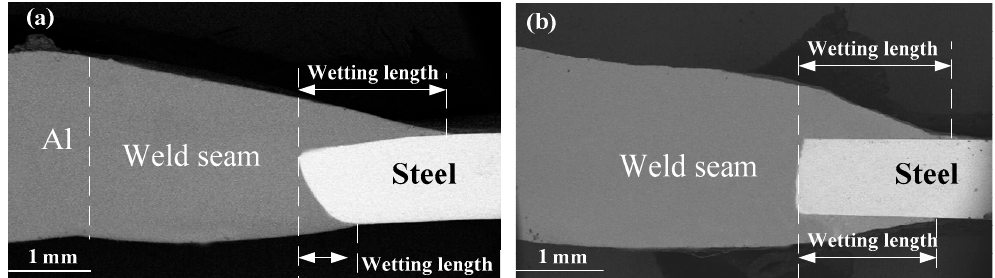
Figure 4. SEM images of the cross-sections of Al-steel butt joints formed by two different welding processes; ( a ) single laser welding brazing, and ( b ) arc assisted laser welding brazing